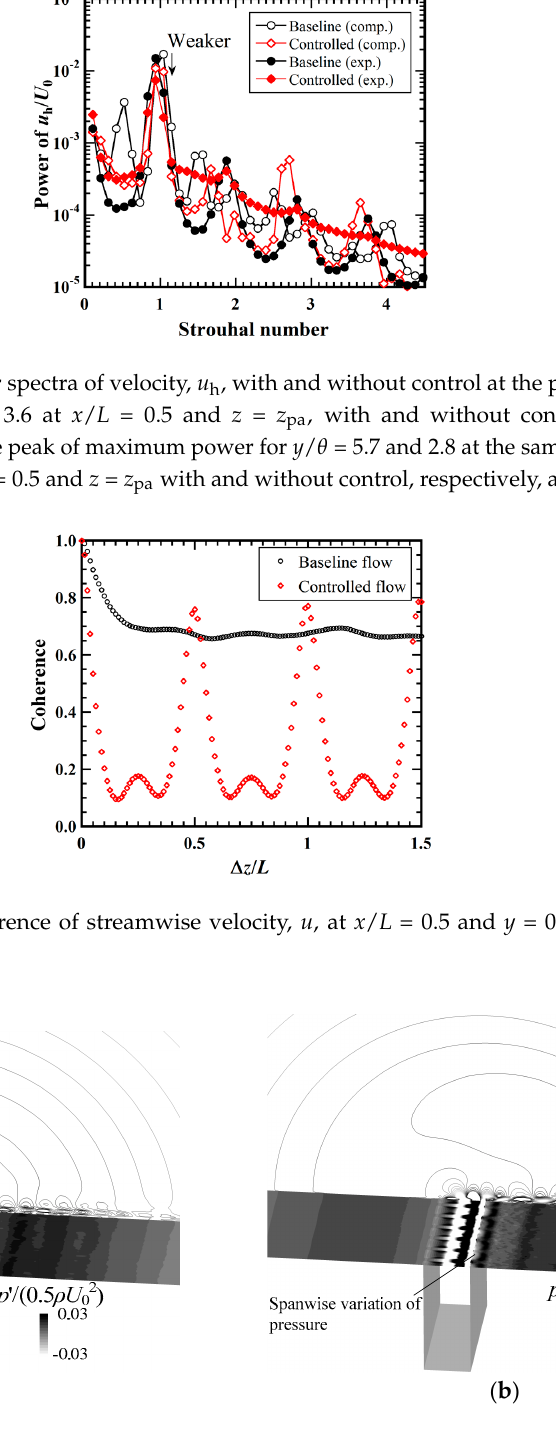
pressure varies in the spanwise direction. This variation also contributes to the weakening of the cavity tone.